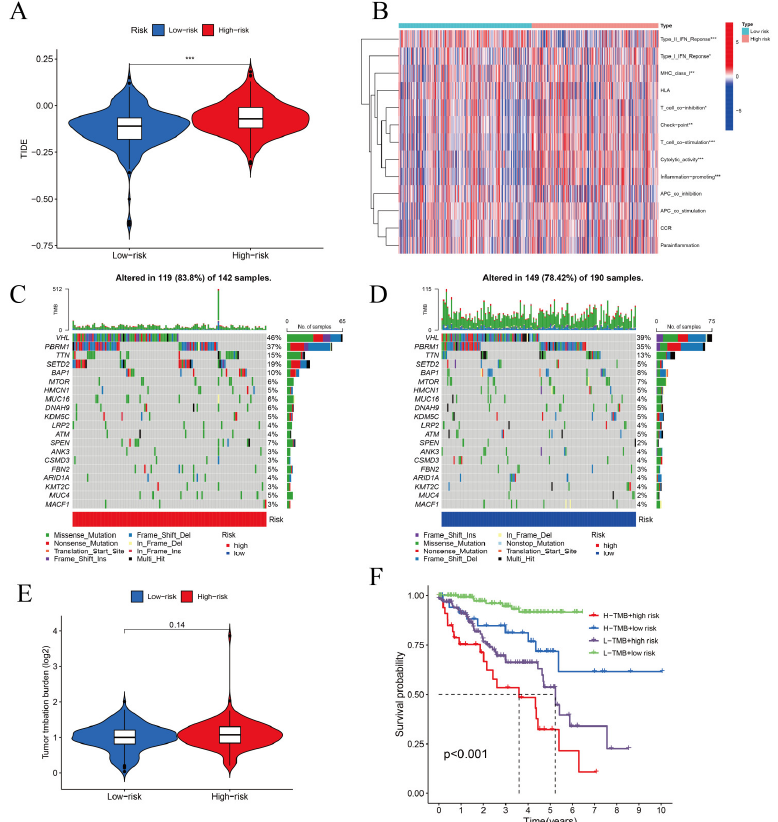
Figure 12. TIDE, Immunotherapy, Mutations, TMB, and Kaplan‒Meier survival analysis. ( A ) TIDE analysis for the high- and low-risk groups (*** p < 0.001). ( B ) Immune indicators for the high- and low-risk groups. ( C ) Top 20 driver genes for the high-risk group. ( D ) Top 20 driver genes for the low-risk group. ( E ) TMB analysis for the two risk groups. ( F ) Kaplan‒Meier survival with TMB status and risk level.